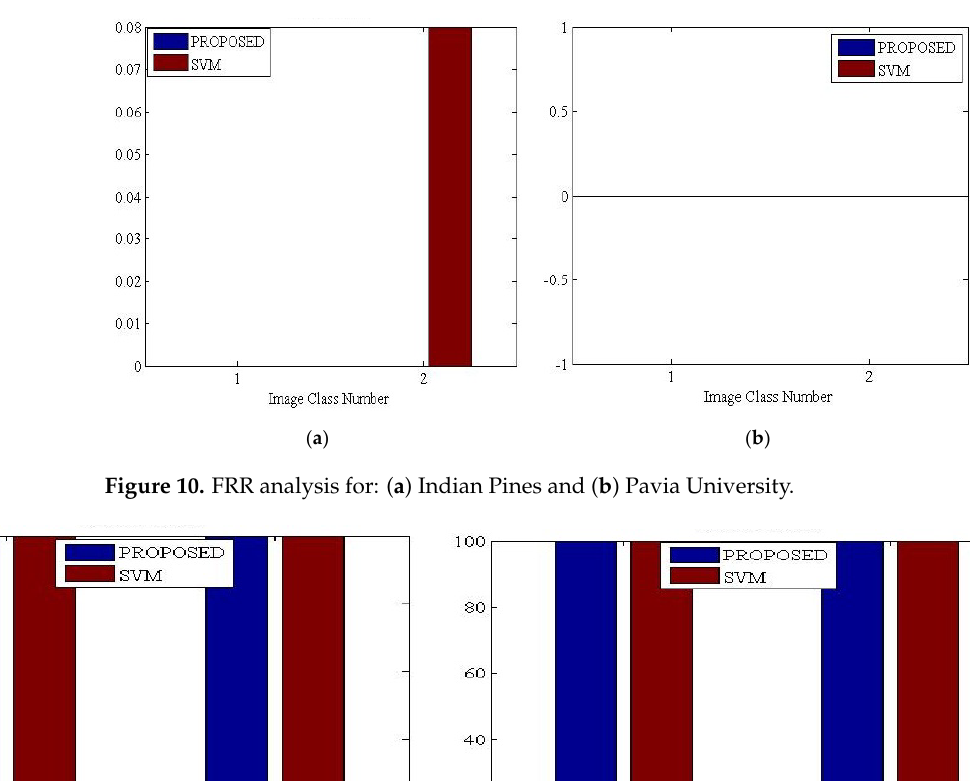
Figure 11. GAR analysis for: ( a ) Indian Pines and ( b ) Pavia University.